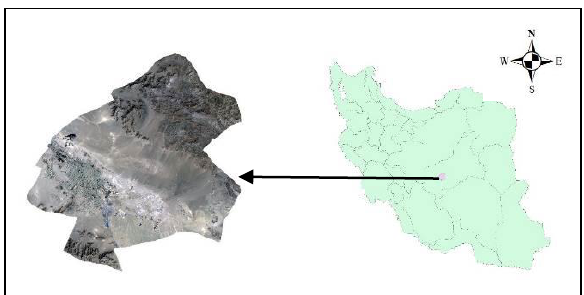
Figure 1. Area under study in Yazd province, Iran.